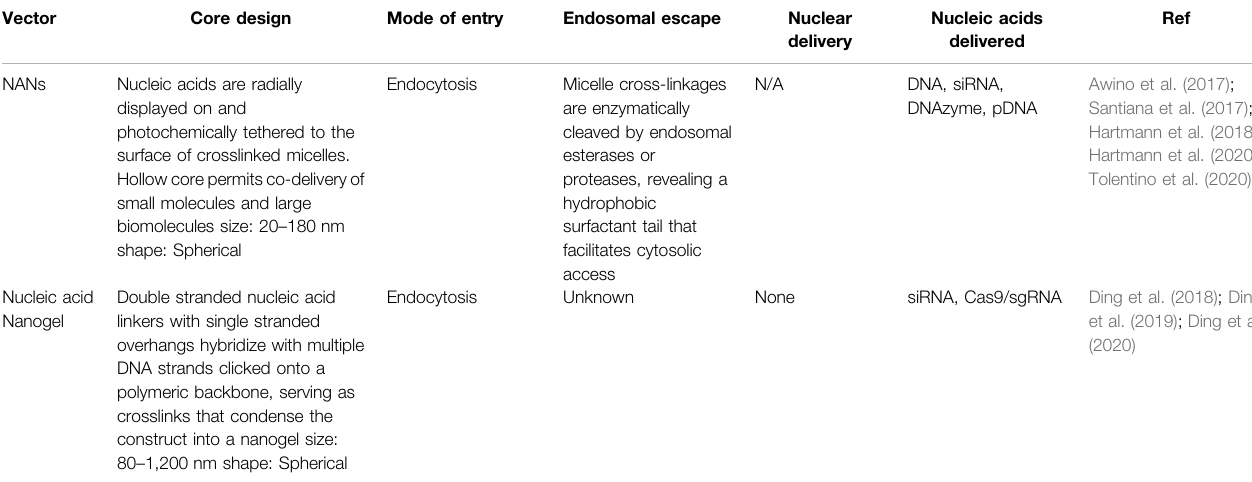
TABLE 1 | ( Continued ) Nucleic acid carriers: Properties and traf fi cking.